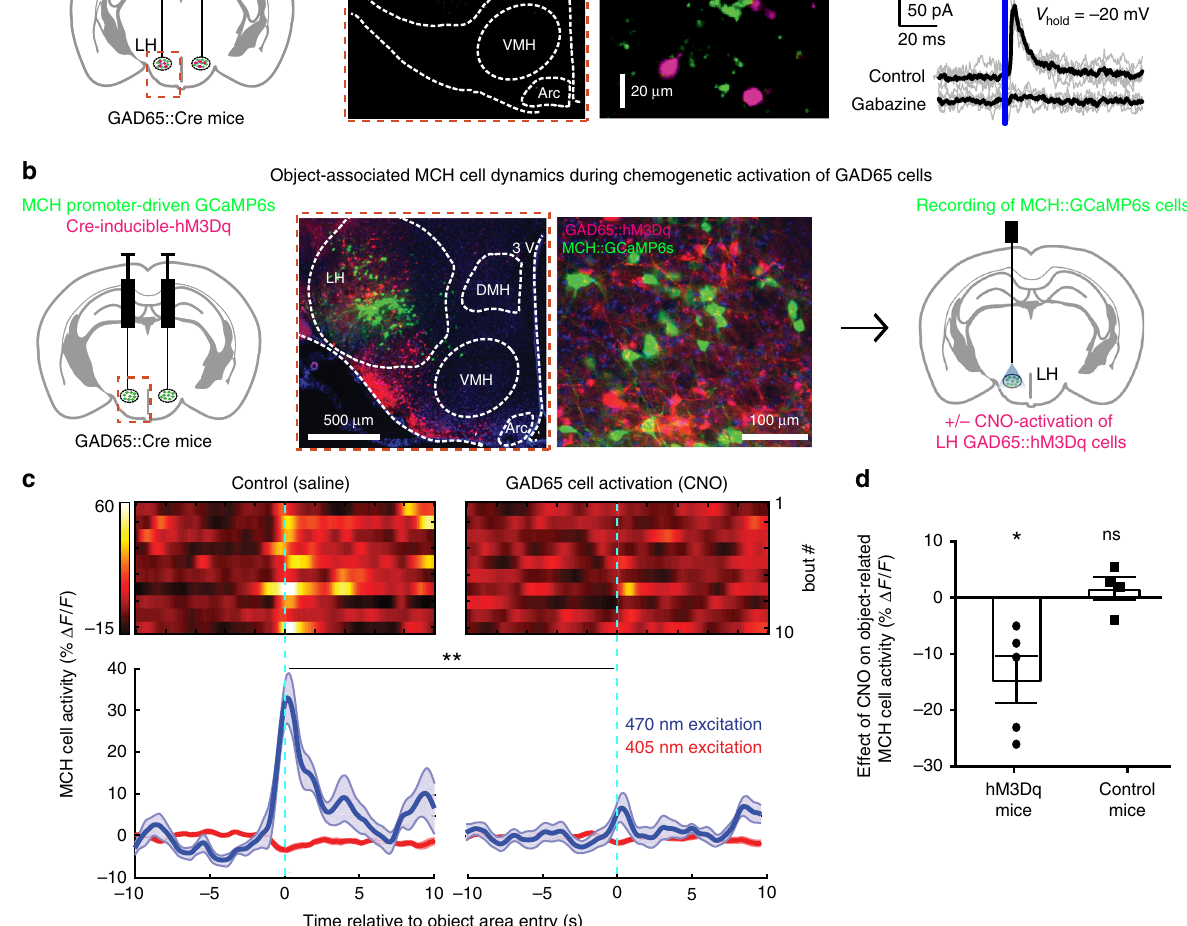
Fig. 3 Identi fi cation of GAD65 → MCH inhibitory microcircuit. a Targeting schematic (left) for expression of ChR2 in GAD65 LH cells and mCherry in MCH LH cells (middle panels). Right, GAD65 LH ::ChR2 optostimulation evokes a gabazine – sensitive current in MCH LH ::mCherry cells. Gray lines are individual trials, black lines are trial averages; n = 14/16 cells were connected; latency between GAD65 LH cell optostimulation and the onset of postsynaptic current: 0.83 ± 0.8 ms ( n = 14 cells), synaptic current size is quanti fi ed in Supplementary Fig. 3C). b Targeting schematic (left) and expression (two middle panels) of GCaMP6s in MCH LH cells and hM3Dq in GAD65 LH cells, for recording of MCH LH ::GCaMP6s cell activity during GAD65 LH ::hM3Dq cell modulation (right). c Top, representative heatmaps of MCH LH ::GCaMP6s fl uorescence (at 470 nm excitation) aligned to object-area entry. First 10 object area entries from one mouse (representative data of n = 5 mice). Bottom, corresponding group data (means ± s.e.m of n = 10 visits), also showing negative control from 405 nm excitation. Chemogenetic activation of GAD65 LH ::hM3Dq cells decreased object-area-entry-associated MCH LH cell activity peaks ( t (18) = 3.805, ** p = 0.0013, unpaired t -test, representative data comparing 10 object encounters before and after CNO from one mouse, group data are given in d ). The late activity at around 5 and 10 s re fl ect activity outside the object area, which was not investigated further. d Group data (individual points and means ± s. e.m), showing effect of CNO (i.e., response in CNO minus response in saline) on peak peri-object MCH LH cell signals in negative control mice (MCH LH :: GCaMP6s, n = 4), and in hM3Dq mice (MCH LH ::GCaMP6s and GAD65 LH ::hM3Dq, n = 5); * p = 0.0257, t (4) = 3.466, one-sample t -test, n = 5 mice; ns = p = 0.4623, t (3) = 0.8406, one-sample t -test, n = 4 into neuromodulation of valued cognitive abilities that are key targets of rehabilitation in neuropsychiatric disease.